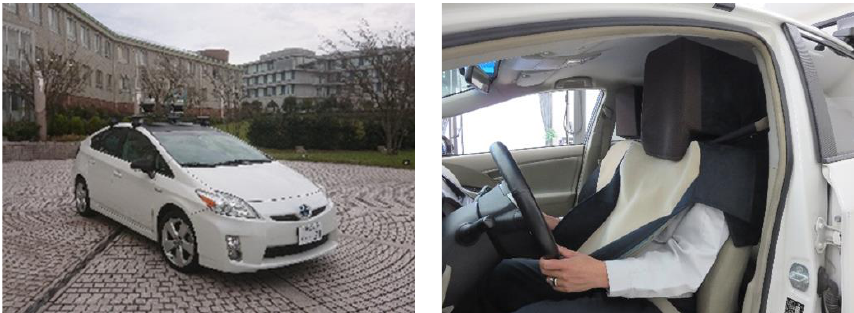
Figure 1. Study area. Participants communicated with vehicle and began crossing from right side of image.